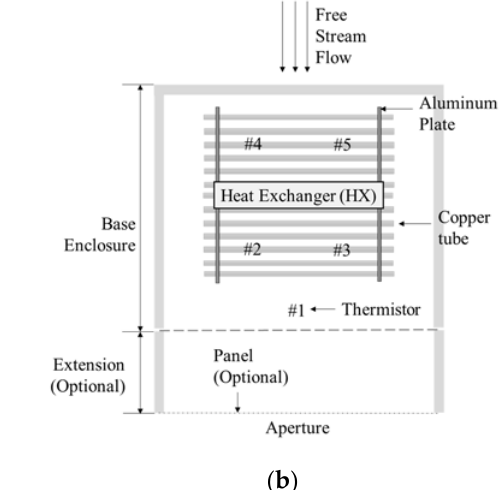
Figure 4. Schematic of ( a ) side view of the enclosure showing the heat exchanger, panel, and exten ‐ sion, ( b ) the top view of the heat exchanger and enclosure configuration with thermistor locations (figure not drawn to scale).